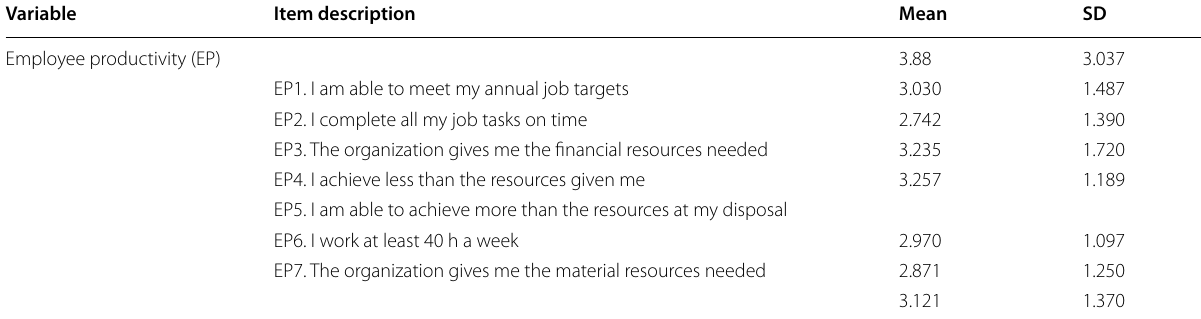
Table 1 Employee productivity Scale